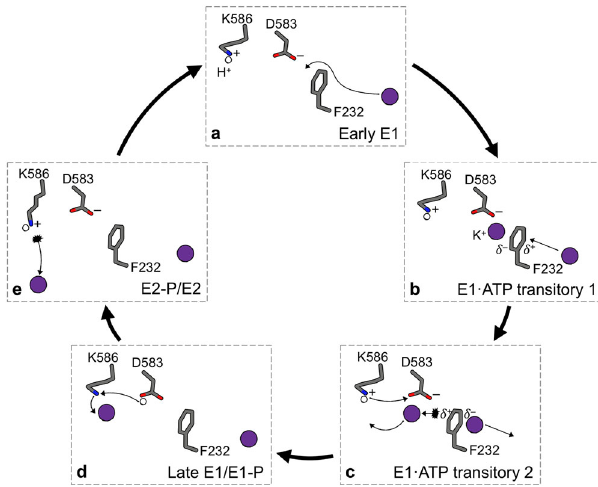
Fig. 6 Molecular mechanism of ion progression in the CBS during the KdpFABC transport cycle. a In the E1 ground state (Early E1), KdpB K586 is protonated and KdpB D583 deprotonated, forming the energy well at the end of the intersubunit tunnel. b ATP binds and a fi rst ion is rapidly pulled past the constriction of KdpB F232 into the PBS, coordinated by KdpB D583 and assisted by cation – π stacking with KdpB F232 (E1·ATP transitory 1). c When a second ion reaches the DBS, π cloud polarization is perturbed, slightly repelling the fi rst ion forward towards the CBS (E1·ATP transitory 2). d Upon a protonation switch between KdpB D583/K586 , the PBS ion moves forward into the CBS, with coordination supported by KdpB K586 (Late E1/E1- P). The energy well in the PBS is lost by protonation of KdpB D583 , preventing the ion from being pulled back or a second ion from being pulled forward from the DBS. e Upon E1-P/E2-P transition, the protonation switches back to its ground state, with a conformational shift of the now positively charged KdpB K586 forcing the ion out of the CBS ( 5 — E2-P/E2). In the E2/E1 transition, KdpB K586 acts as a built-in